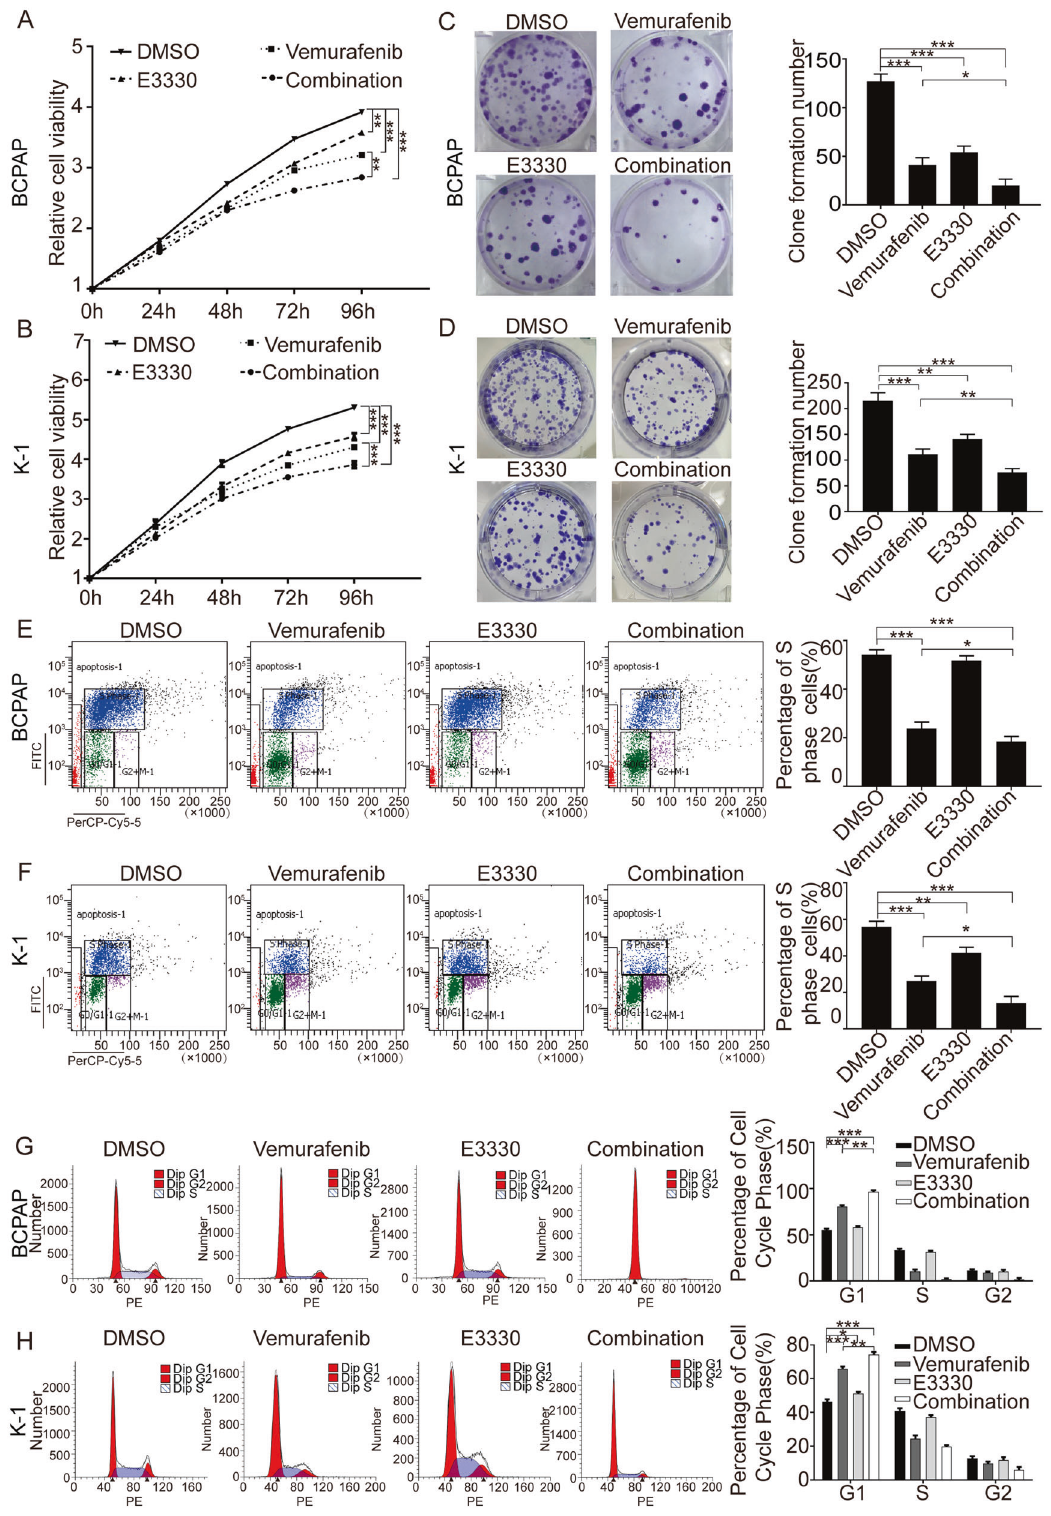
Fig. 3 E3330 enhanced the antiproliferative capacity of vemurafenib in BCPAP and K-1 cells. A , B Cell viability detection by a CCK-8 assay was used to quantify cell proliferation in BCPAP and K-1 cell lines. C , D Cell proliferation detection by colony-formation assay in BCPAP and K-1 cell lines. E , F Cell division detection by BrdU assay in BCPAP and K-1 cell lines. G , H The cell cycle distribution detection by fl ow cytometric assay in BCPAP and K-1 cell lines. BCPAP and K-1 cell lines were pretreated with DMSO, vemurafenib (10 μ M), E3330 (50 μ M), and combination (10 μ M vemurafenib + 50 μ M E3330), respectively. * P < 0.05, ** P < 0.01, *** P < 0.001.